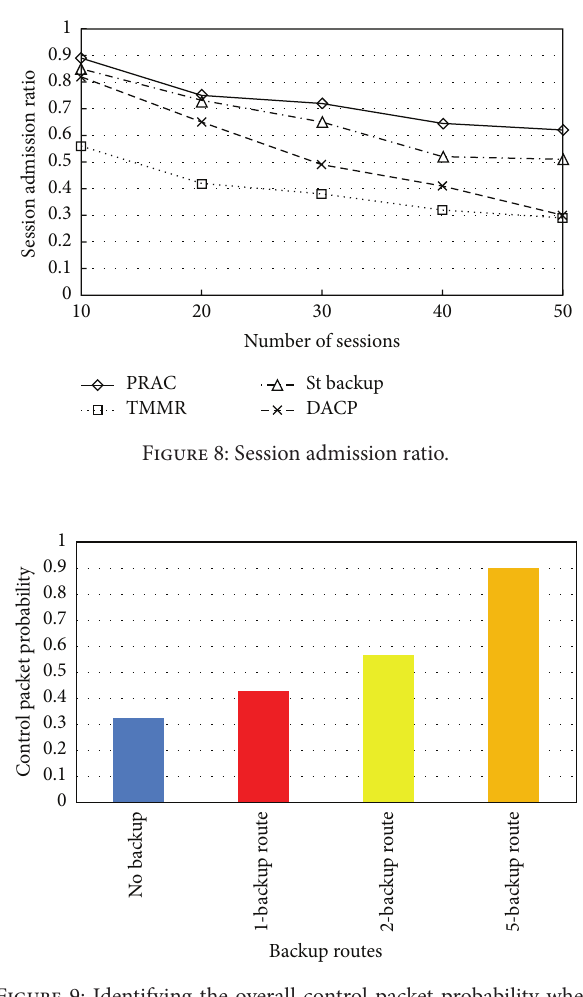
Figure 9: Identifying the overall control packet probability when using different backup